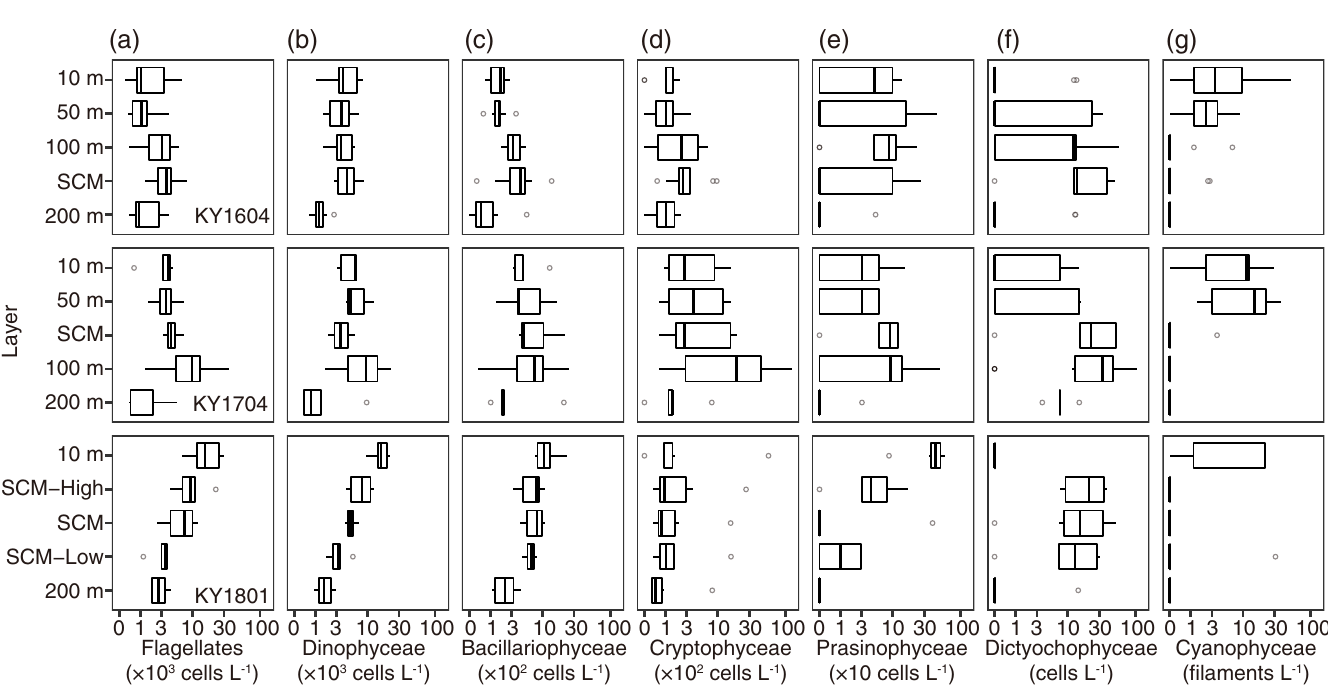
Fig 4. Vertical distributions of densities of the seven major plankton groups, i.e., (a) flagellates, (b) Dinophyceae, (c) Bacillariophyceae, (d) Cryptophyceae, (e) Prasinophyceae, (f) Dictyochophyceae, and (g) Cyanophyceae ( Trichodesmium spp.) for KY1604 (top), KY1704 (middle), and KY1801 (bottom) cruises. The thick vertical line in each box represents the median values. Boxes indicate the lower and upper quartiles. Horizontal lines extending from each box represent the minimum and maximum values. The open circles are outliers. The x-axes are transformed logarithm values.